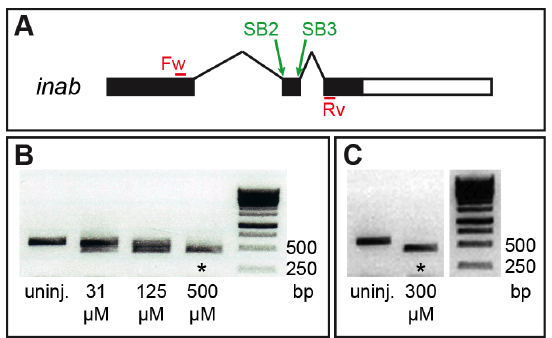
Figure 1. Splice-blocking MOs effectively disrupt inab . ( A ) Schematic of the inab gene. inab has three exons and two introns. Splice-blocking (SB) MOs target various splice sites in the gene. SB2 targets the intron1/exon2 boundary, and SB3 targets the